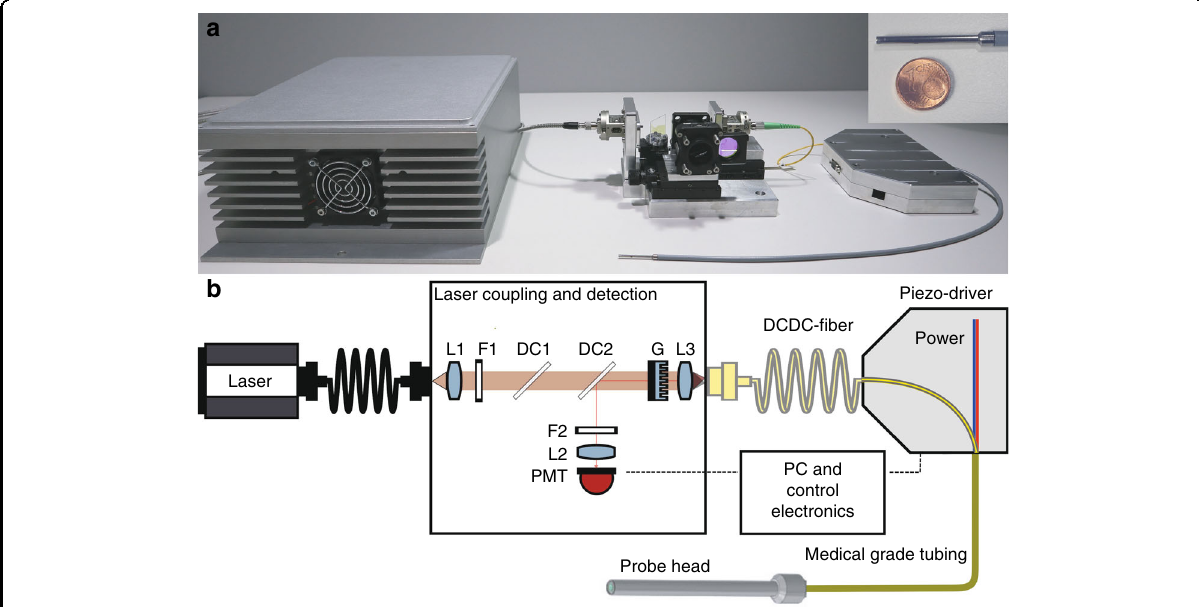
Fig. 2 Experimental set-up for multimodal non-linear DCDC fi ber scanning CARS/SHG/TPEF endoscopy. a Photo of the endomicroscopic fi ber probe and laser coupling unit. A picture of the stainless steel shielded probe head of 2.4 mm diameter and a length of 39 mm is shown in the upper right corner in comparison with the size of one Euro cent coin. The optical fi ber and the four connection cables of the piezo-scanner are guided in a 1 mm tube, which is enclosed in a sealed medical-grade endoscopic tube of 4.5 mm in diameter. b The fi ber laser (AFS, Germany) is collimated by the lens L1 ( f = 3 mm), fi ltered from FWM at the CARS wavelength by F1 (750 nm long pass). The laser power is adjusted using a 1050 nm short pass dichroic mirror (DC1). A linear diffractive grating G of 39.4 μ m grating period and lens L3 ( f = 4 mm) couple pump and Stokes-wavelengths into the two different cores. Sample signals are guided back through the DCDC fi ber and detected by the PMT detector after de fl ection at the dichroic mirror DC2. The bandpass fi lter F2 is selecting the non-linear signal of interest (CARS/SHG/TPEF) and the lens L2 focusing the signals onto the